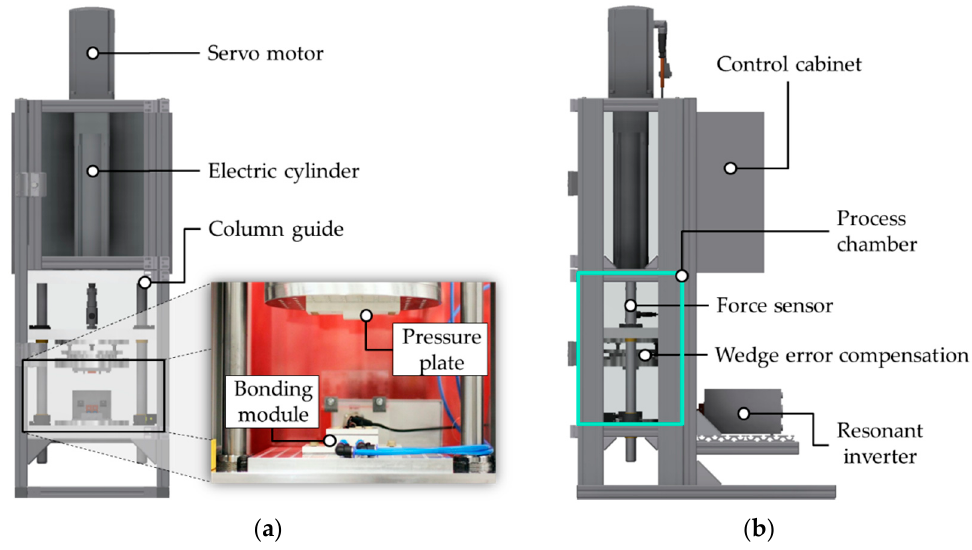
Figure 15. Inductive bonding system with mechanical drives, wedge error compensation, process chamber, bonding module, and resonant inverter: ( a ) Front view; ( b ) Side view.